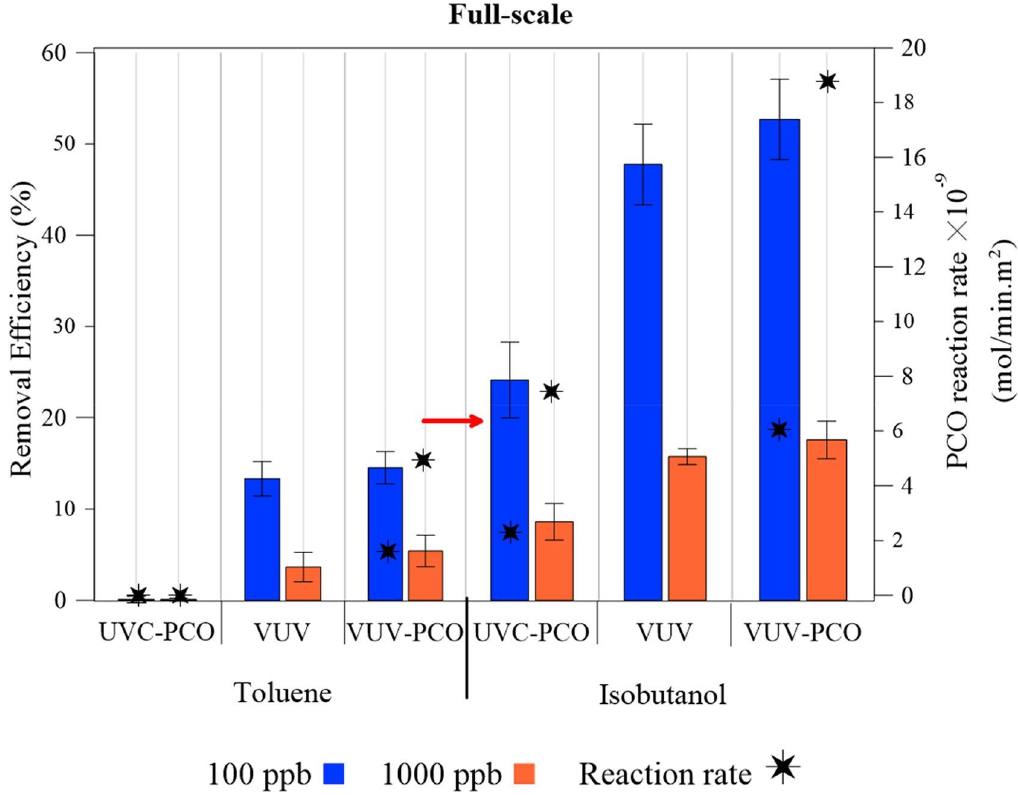
Figure 12. Removal efficiency of toluene and isobutanol and PCO reaction rate for different systems (UVC-PCO, VUV photolysis, and VUV-PCO) (V = 1.25 m / s) [177]. PCO: photocatalytic oxidation; UVC: ultravacuum, VUV: vacuum ultraviolet.